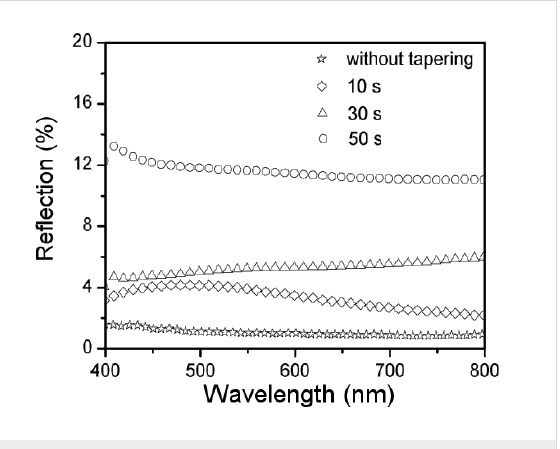
Figure 3: Reflection spectra of SiNWs in the visible spectral range without tapering and after 10, 30, and 50 s of tapering. morphology of PEDOT can be further investigated, as will be discussed